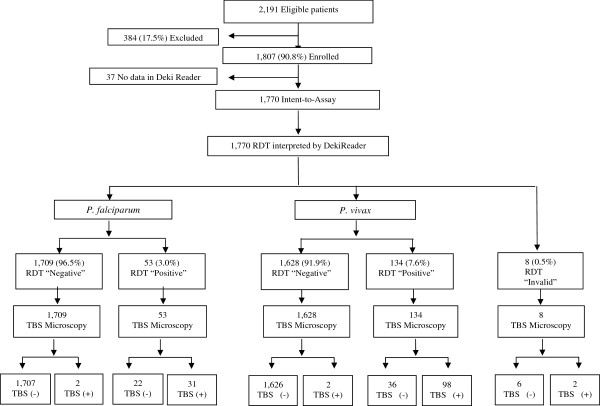
Patient flowchart for Deki Reader RDT results.